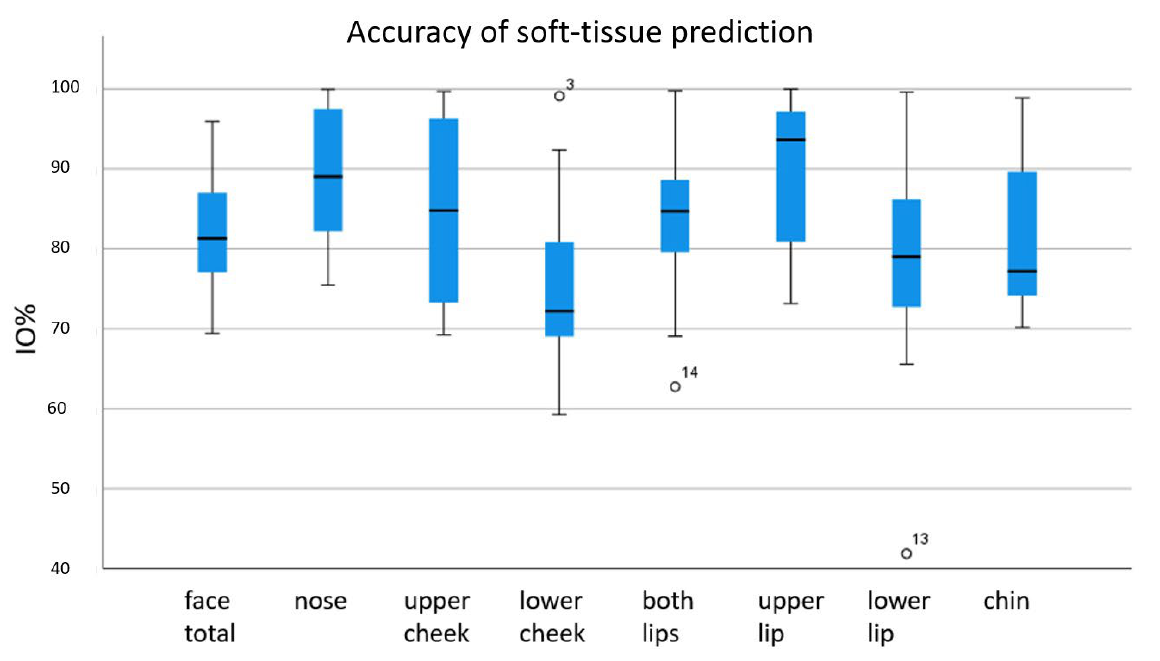
Figure 3. Percentage of correctly predicted soft-tissue: Surface congruence ± 2 mm. ◦ : moderate outlier: 1.5–3.0 × IQR (interquartile range).